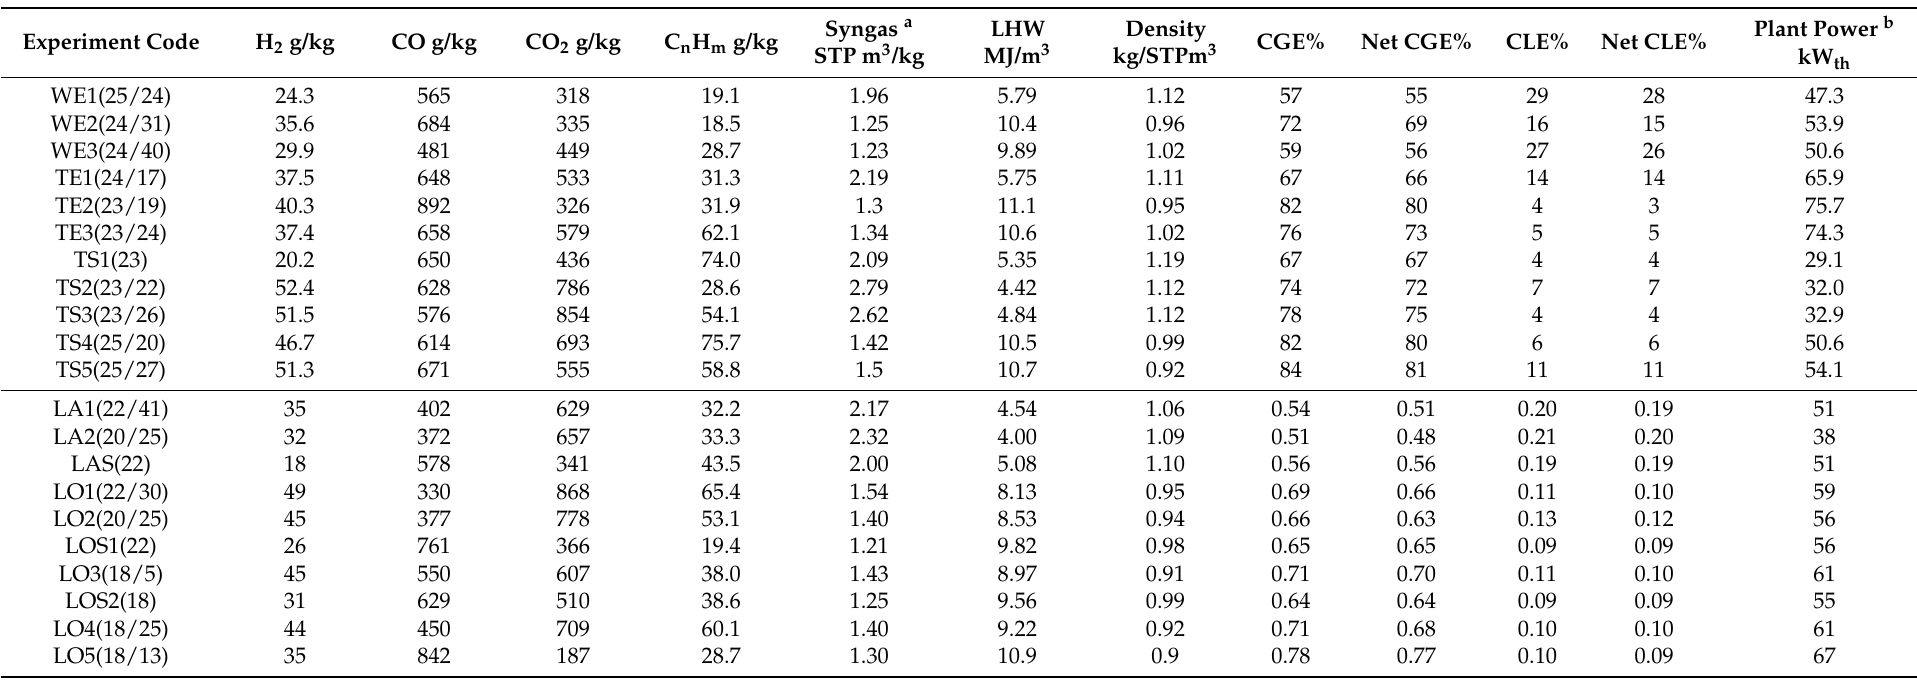
Table 7. Process yields per kg of dry feedstock and plant performances